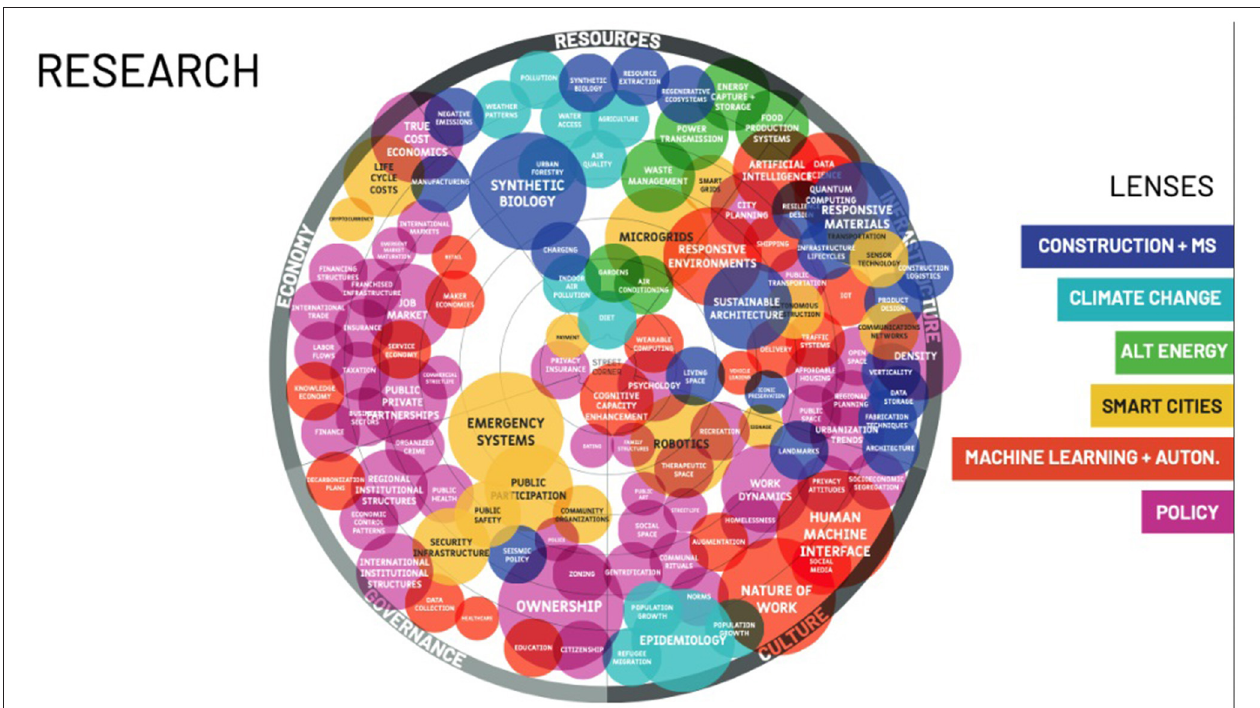
FIGURE 1 | The Mandala system of organizing research, developed by Alex McDowell. The Mandala system is a way of integrating diverse aspects of research on cultural, political, ecological, infrastructural, and economic factors of the urban area in question, and assessing their relationships at a range of scales, from the city down to the individual. Findings were additionally organized according to lenses identified as important by the project client, indicated in the list at right (ASCE and Experimental Design, 2020; Experimental Design,